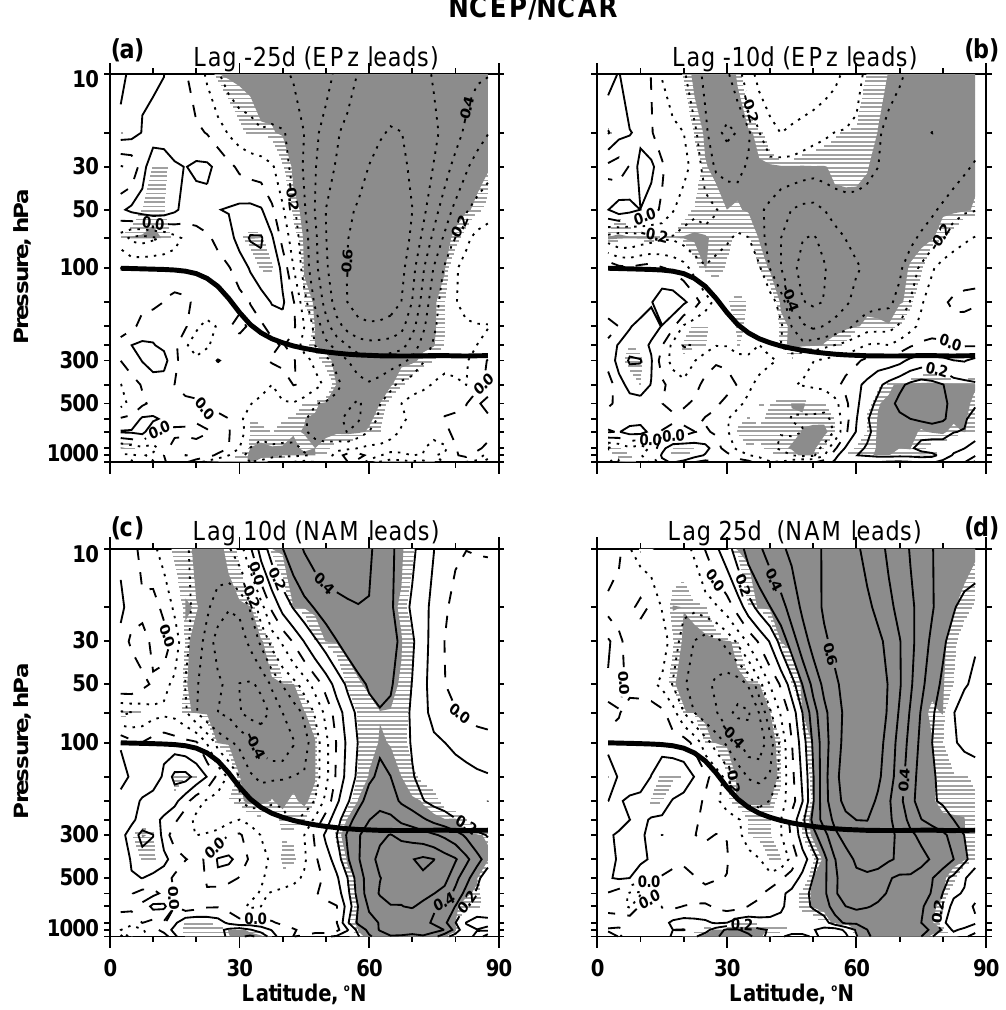
Fig. 7. Cross correlation of the 60-day low-passed NAM index at 20hPa with the 60-day low-passed vertical EP flux anomalies. Cross- correlations are taken at lags (a) − 25, (b) − 10, (c) 10 and, (d) 25 days. Contours and shading as in Fig. 2. The NCEP-NCAR reanalysis.